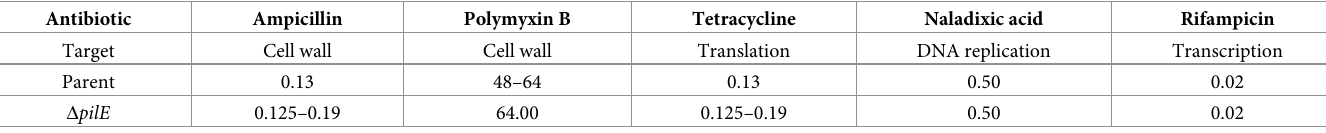
Table 1. Antibiotic sensitivity of the piliated parent and a pilE mutant.